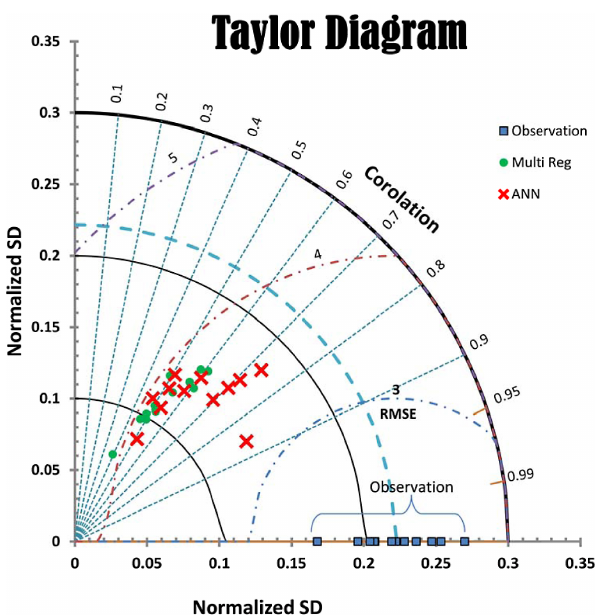
Figure 3. Scatterplot of the predicted data of the regression and ANN models on a Taylor diagram.